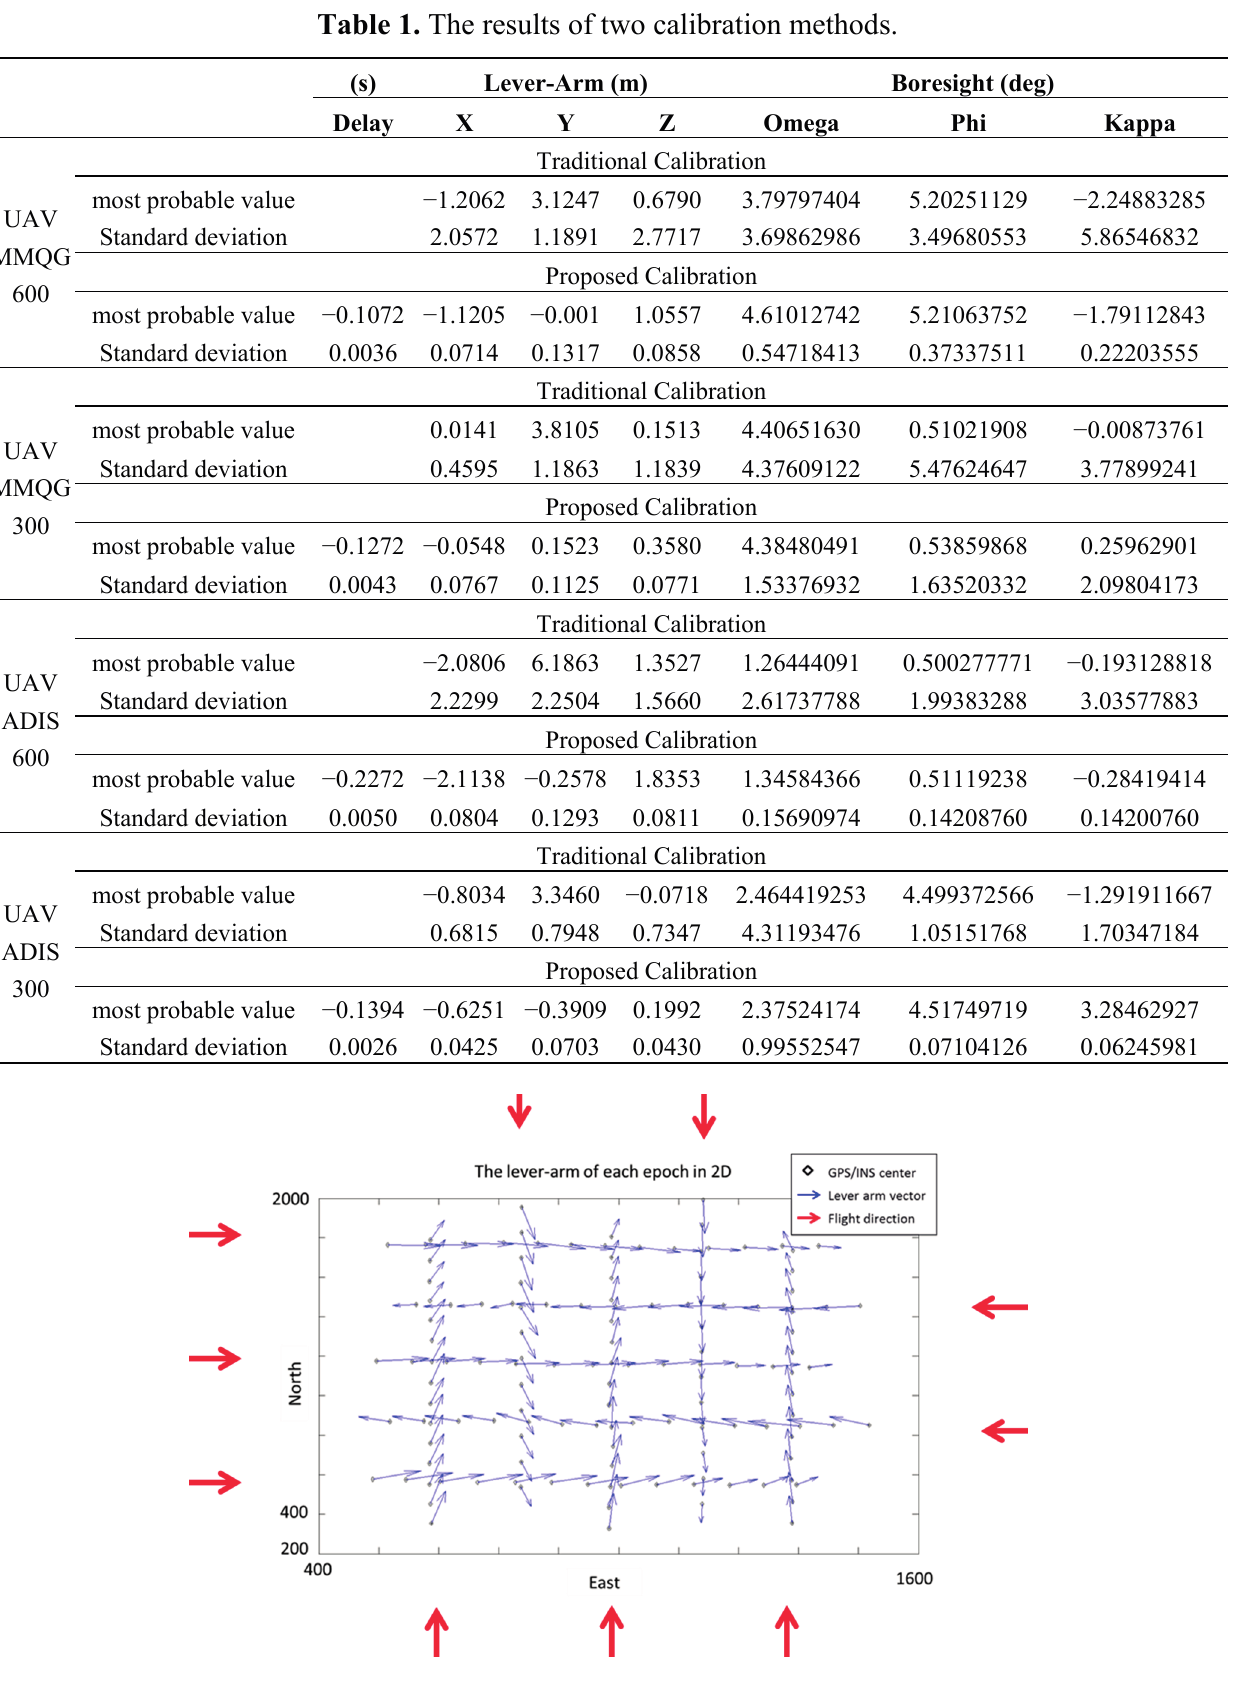
Figure 22. The lever-arm of each